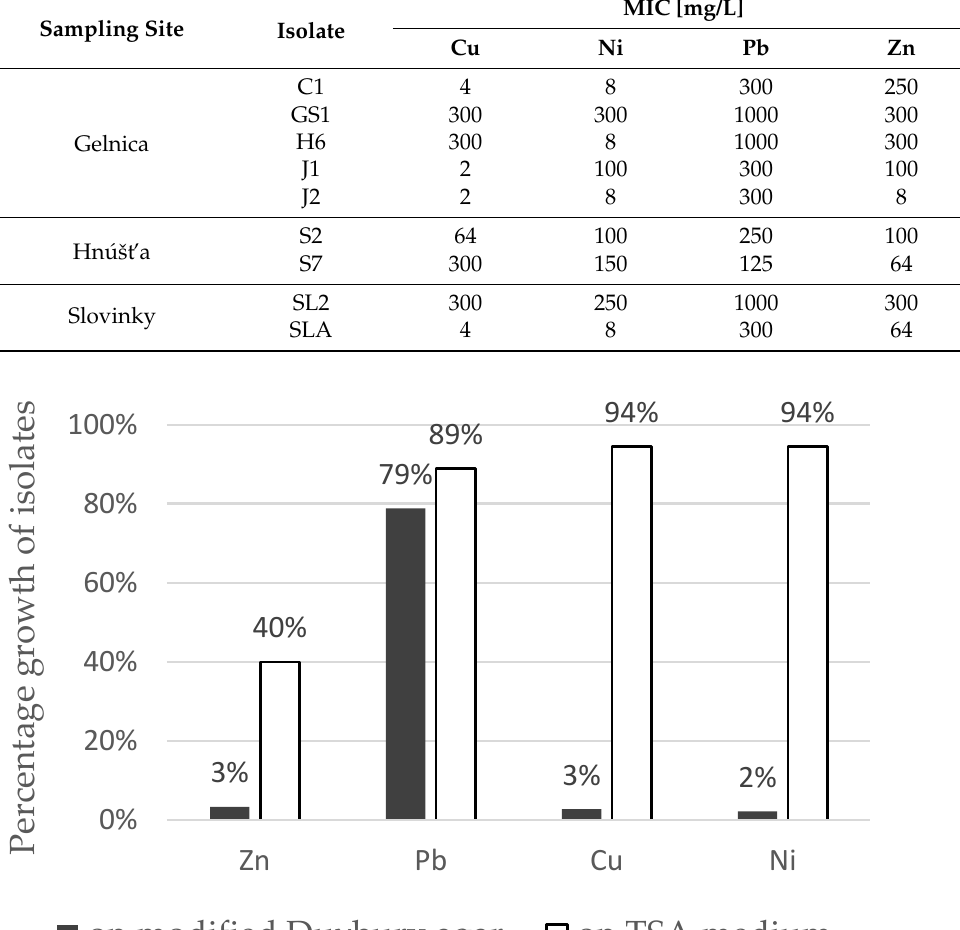
Figure 2. Percentage growth of isolates on modified Duxbury agar medium and Tryptic Soy Agar (TSA) medium with Zn, Pb, Cu and Ni at concentration 64 mg/L against control (media without metal).